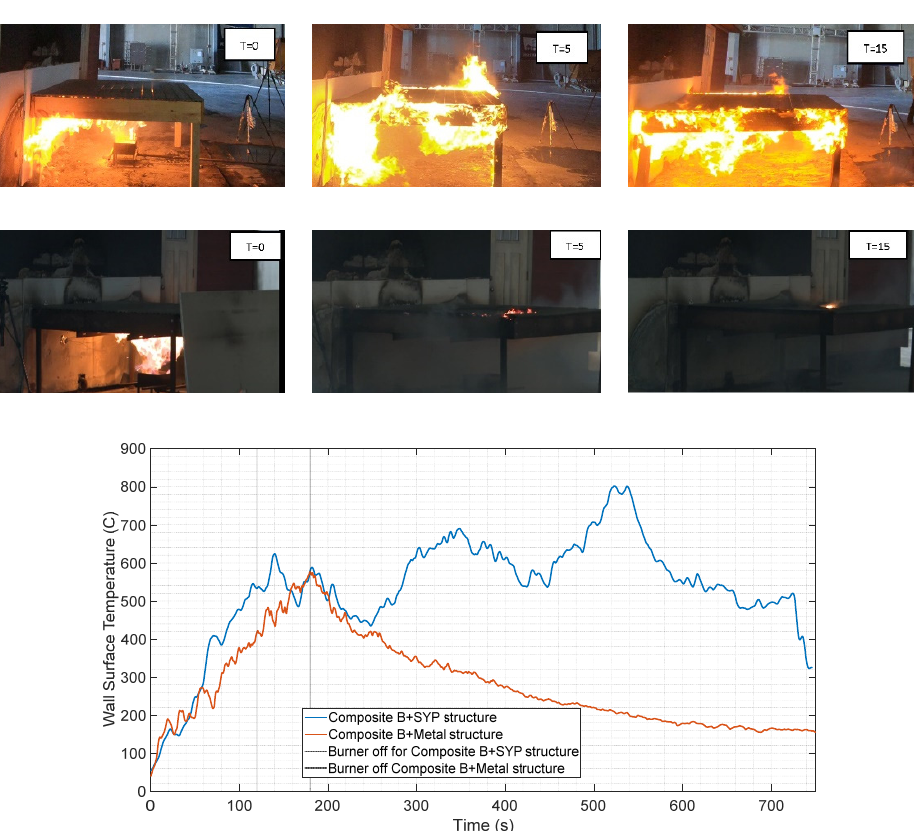
Figure 18. Time-lapse of Composite A deck boards with ( First Row ) Southern Yellow Pine joists and ( Second Row ) metal supporting system, and the wall temperature.